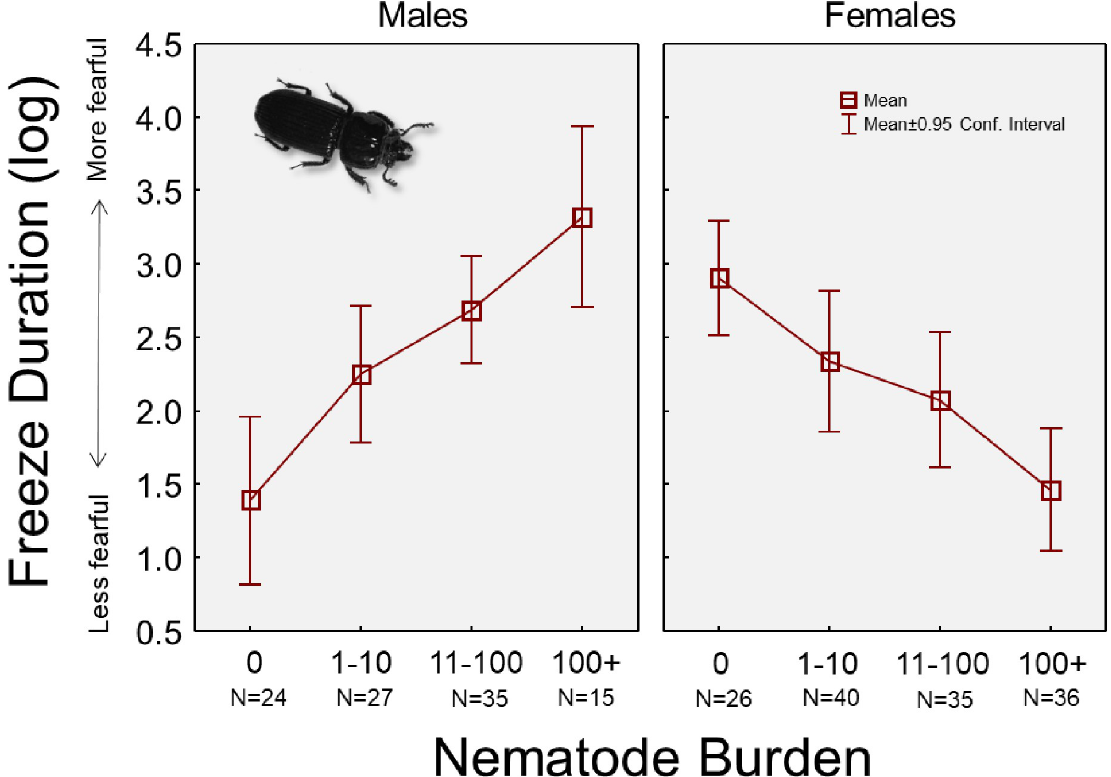
Fig 3. Mean freezing time for all beetles in each nematode infection category, and comparing males versus females. There was a significant sex � infection interaction term in the model examining predictors of immobility duration (see Table 2). Immobility (freezing) is generally associated with boldness/fearfulness, such that bolder or less fearful individuals tend to show short immobility